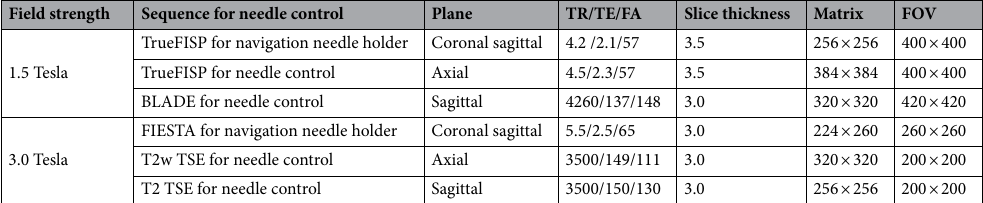
Table 1. Sequence protocol of MRI guided in-bore biopsy. TrueFISP true fast imaging with steady state precession, BLADE motion insensitive multi-shot turbo spin echo sequence, FIESTA fast imaging employing steady state acquisition, TSE turbo spin echo.